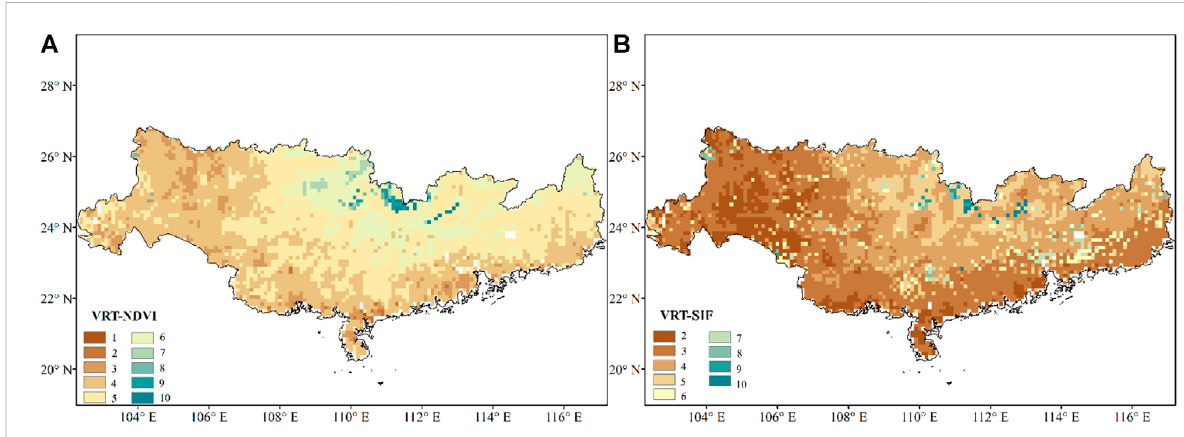
FIGURE 7 Spatial distributions of the fi nal VRT based on (A) the NDVI and (B) SIF.